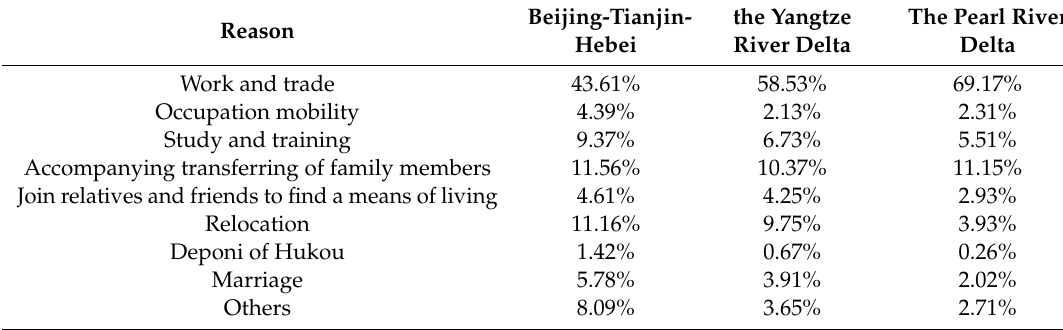
Table 1. Migration population percentage of di ff erent migration reason in the di ff erent urban